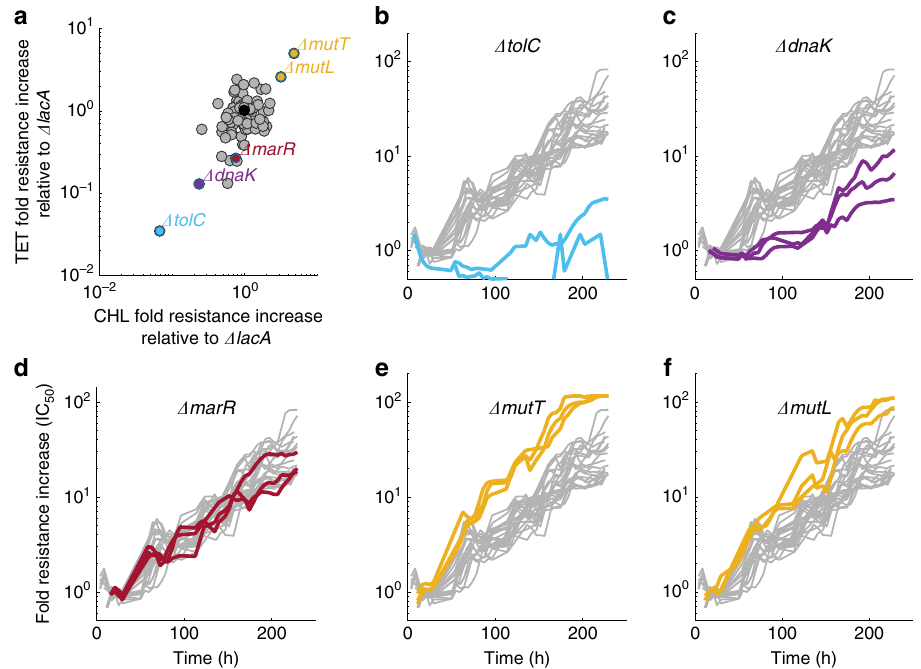
Fig. 5 Changes in resistance evolvability are correlated across different antibiotics. a Fold increases in resistance to tetracycline ( y -axis) and chloramphenicol ( x -axis) of individual gene deletions after 180 h of evolution divided by the mean fold increase in resistance for the reference strain ( Δ lacA ) (shown in black). The relative fold increases are correlated (Pearson ’ s r = 0.63, p < 10 − 8 ). b – f Examples of resistance increase over time for chloramphenicol (CHL) for the strains highlighted in ( a ). The apparent plateauing of resistance for Δ mutT occurred because the concentration needed to keep the strains inhibited reached the maximum stock concentration used on that day. Gray lines show resistance over time for 23 replicates of the reference strain ( Δ lacA ) for comparison. Data are from experiment M4 (Methods, Supplementary Table 2, Source